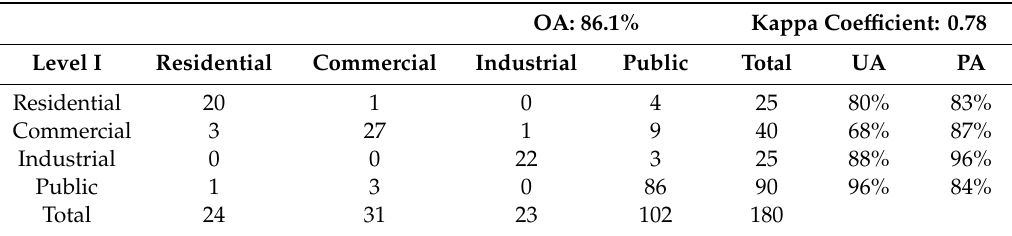
Table 5. Confusion matrix for Level I categories in